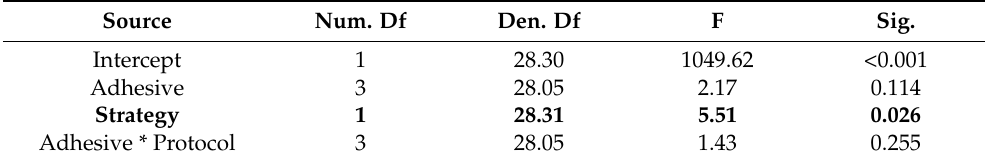
Table 4. Tests for type III fixed effects (LMM) of µ TBS